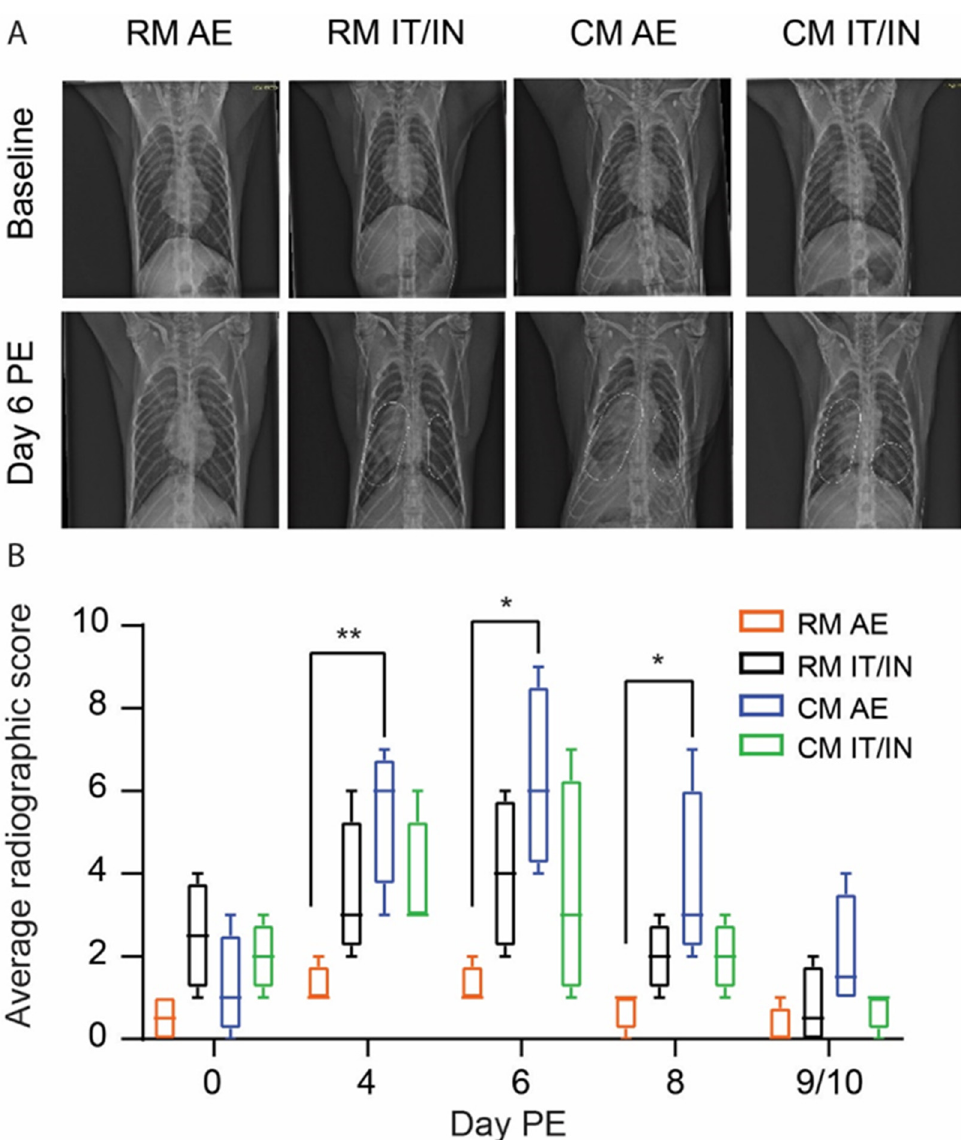
Figure 4. Evidence of clinical disease in radiographs from rhesus (RM) and cynomolgus macaques (CM) infected with SARS-CoV-2 by aerosol (AE) or intratracheal/intranasal (IT/IN) exposure. ( A ) Representative radiographs are shown from each group. All images are ventrodorsal. The white dashed lines shown in the Day 6 PE images from RM IT/IN, CM AE, and CM IT/IN outline infiltrates and opacity present in those images; no dashed lines are shown in RM AE due to the absence of lesions. Baseline radiographs were obtained prior to exposure (Day 2). ( B ) Average radiographic scores per group over the course of the study. Box-and-whisker plot showing the range of the data. A non-parametric one-way ANOVA (Kruskal–Wallis test) was performed for each day. The * and ** denote p-values of less than 0.05 and 0.01, respectively.